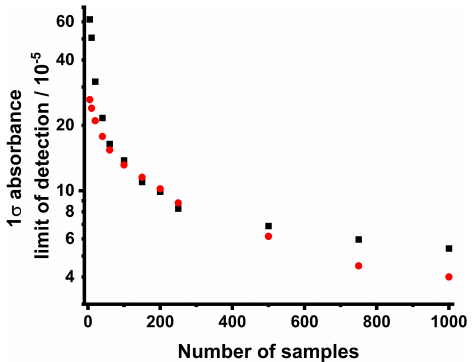
Figure 9. Variation in the 1 σ limit of detection with the number of samples, which is equivalent to the number of photolysis shots for measurements involving reactive species. The 1 σ limit of detection is defined as the standard deviation of the baseline absorbance and is given for the time period equivalent to the pre-photolysis period ( − 4000 to − 500µs, where t = 0 is the time at which the photolysis laser is fired) for measurements of reactive species. Measurements are shown for the traditional oscilloscope (LeCroy WaveRunner-2, LT262, 350MHz, 1GSs − 1 sample rate, 8bit resolution) in black and the PicoScope (Pico Technology, PicoScope 6402C, 250MHz, 5GSs − 1 sample rate, 12bit resolution) in